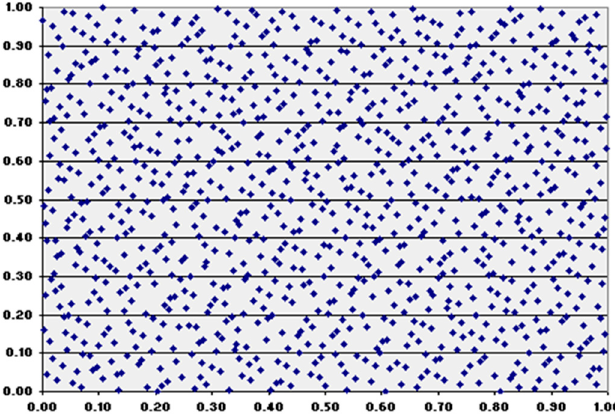
Figure 9. Halton sequence after 1000th iteration.